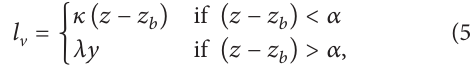
Figure 3: Location of the viewers within the study